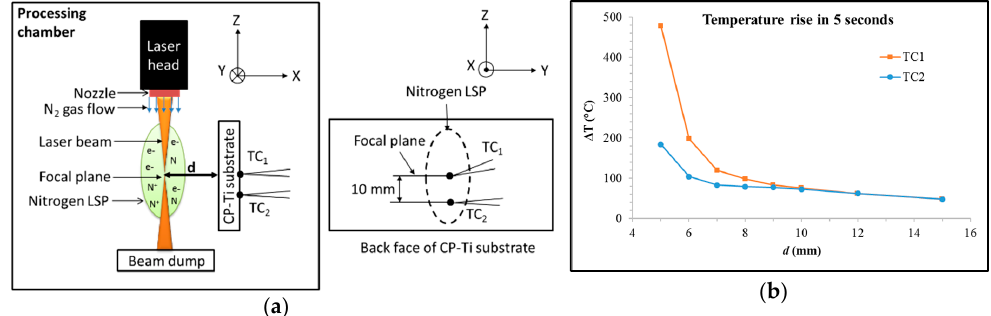
Figure 8. ( a ) Schematic of temperature measurement in parallel configuration with location of the thermocouples; ( b ) temperature rise, Δ T (°C), recorded by two thermocouples TC 1 and TC 2 at the end of 5 s.